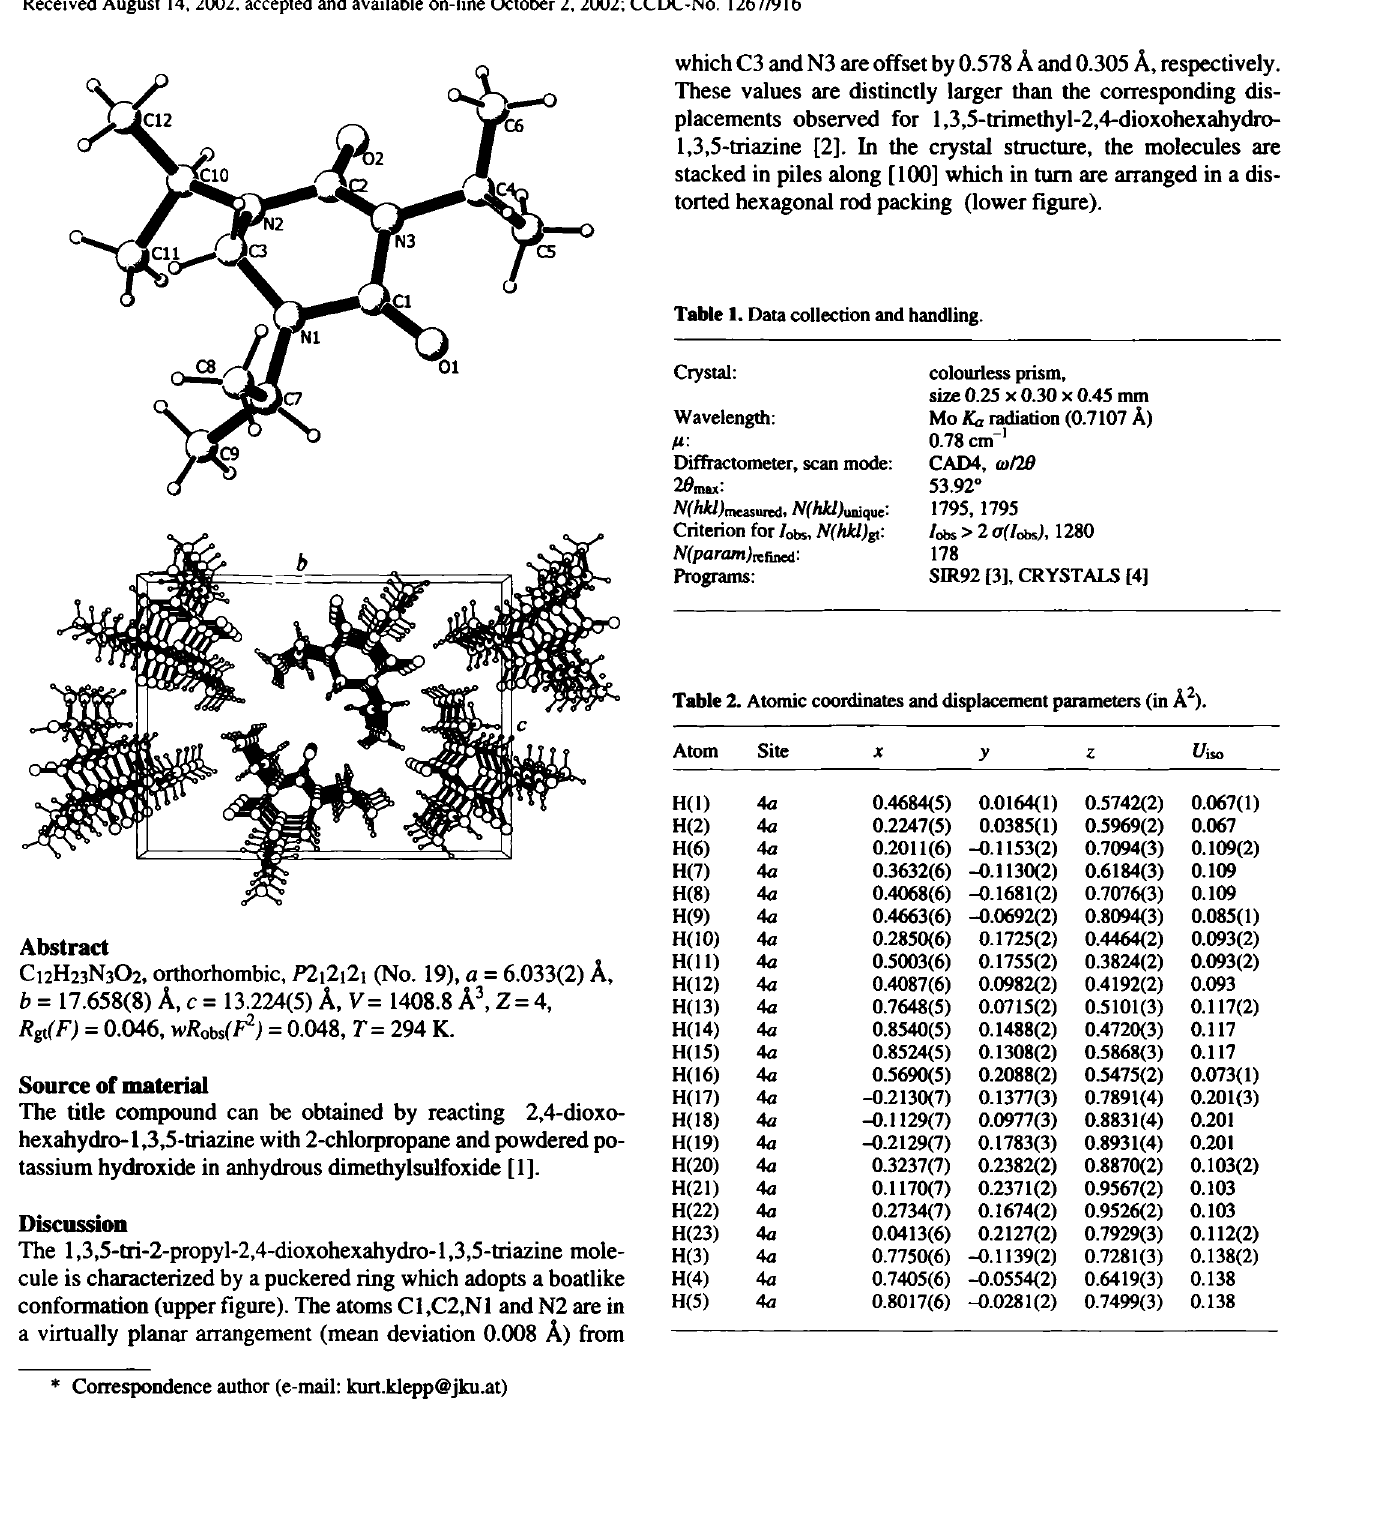
Table 1. Data collection and handling.